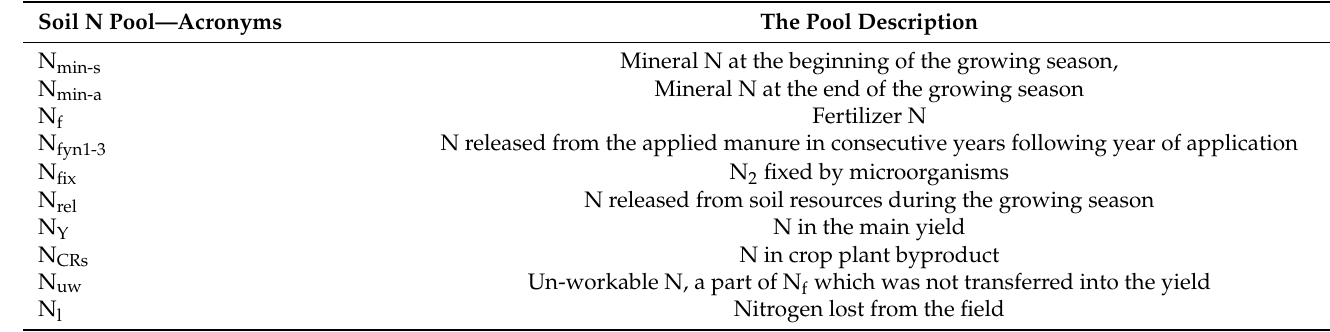
Table 6. The soil nitrogen pools—components of the N balance, kg ha − 1 . Soil N